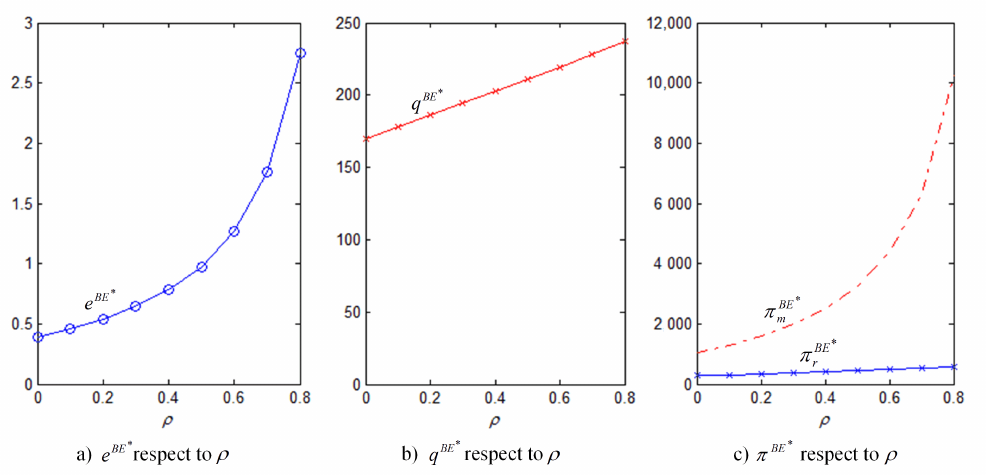
∗ ∗ ∗ ∗ , q BE , π BE m , π BE r with respect to ρ ( θ = 5, r b = 0.1, η =